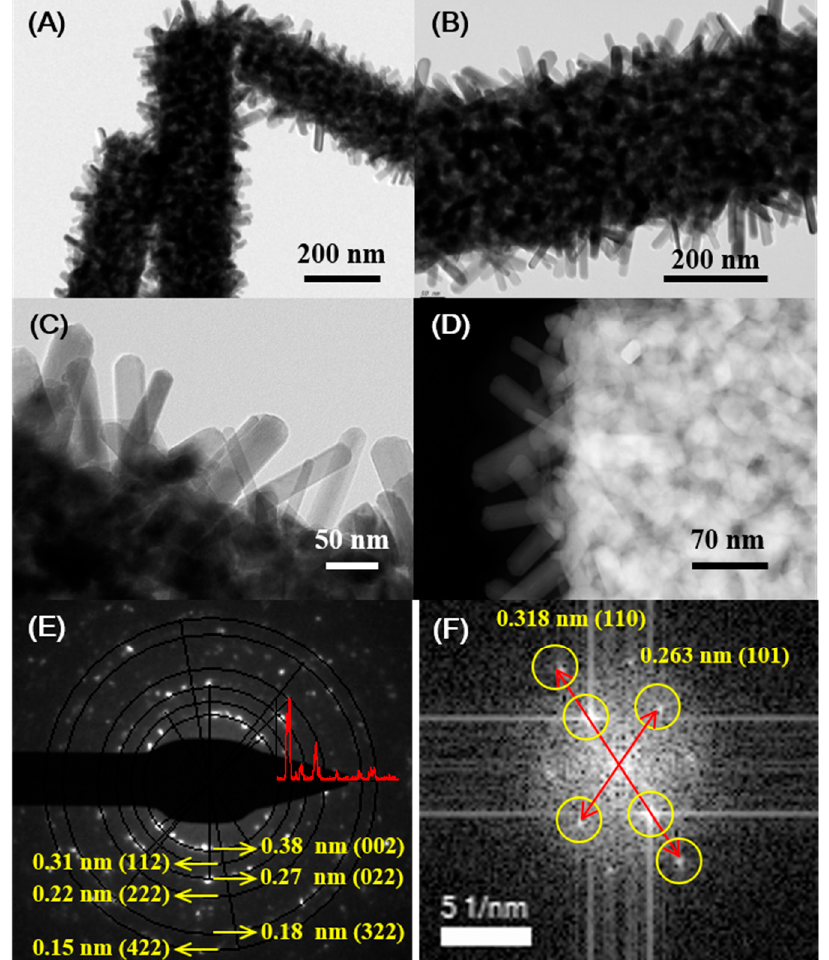
Figure 3. ( A ) and ( B ) low magnification TEM images for RuO 2 nanorods on a single WO 3 nanofiber. ( C ) The high resolution TEM image for RuO 2 nanorods on a single WO 3 nanofiber. ( D ) The bright field TEM image for RuO 2 nanorods on a single WO 3 nanofiber. ( E ) and ( F ) SAED pattern for a WO 3 nanofiber and fast Fourier transform (FFT) of the lattice-resolved image for a single RuO 2 nanorod.